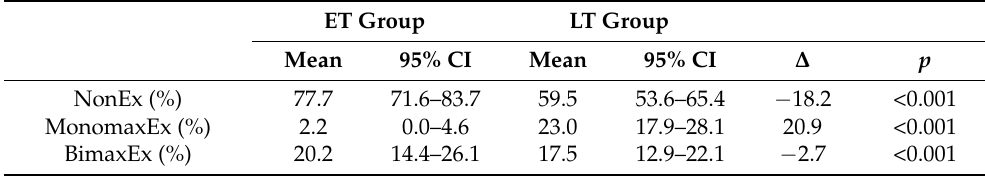
Table 3. Percentage of extraction need for full fixed appliance (FFA) patients.